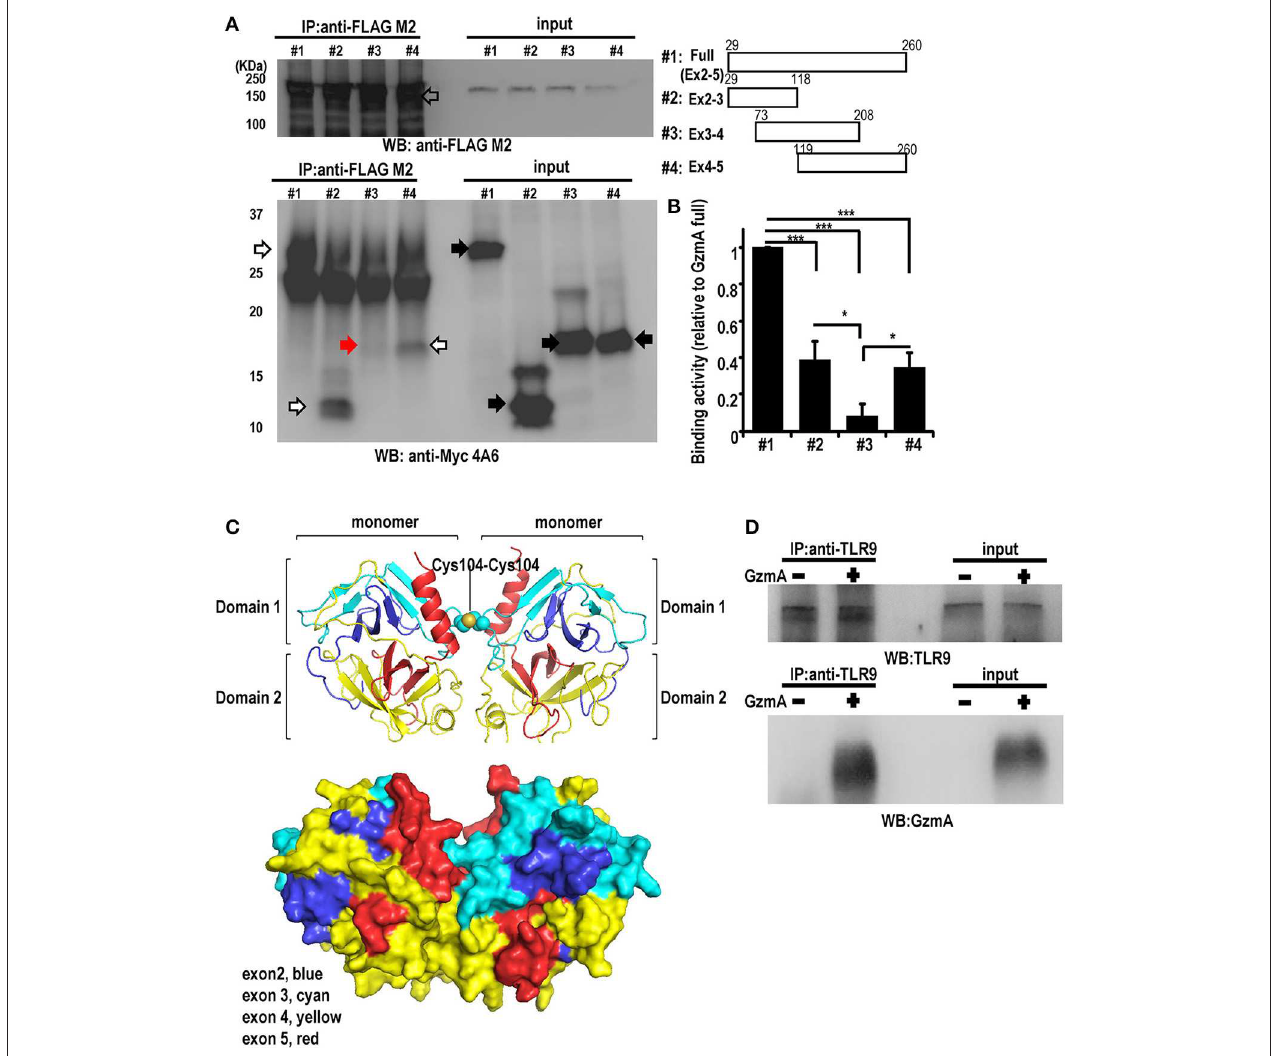
FIGURE 4 | Interaction between GzmA and TLR9. (A) Co-immunoprecipitation western blot (WB) assay for the interaction between GzmA and TLR9. cMyc-tagged full-length or truncated GzmA proteins (right) and flag-tagged TLR9 protein were expressed in HEK293T cells (left). Whole-cell lysates were subjected to immunoprecipitation using anti-Flag Ab and immunoblotted with anti-cMyc Ab. (B) Quantification of binding activity was assessed by the ratio of IP-GzmA (white and red arrows) (lower left): the ratio of input GzmA (black arrow) was calculated from that of full-length GzmA (mean ± SEM, n = 4). * p < 0.05 ; *** p < 0.001 (one-way ANOVA test with Tukey’s post-hoc test). (C) 3D structural model of mouse GzmA dimer (upper panel) generated using SWISS-MODEL Repository with its surface representation in the same view (lower panel) (72, 73). GzmA monomers are colored by exon (exon2, blue; exon 3, cyan; exon 4, yellow; exon 4, red). The Cys104-Cys104 disulfide bond between monomers is shown by spheres. This figure was created with the program PyMOL. (D) Co-immunoprecipitation western blot (WB) assay for the interaction between GzmA and TLR9 in primary FL-DCs. Whole-cell lysates were harvested 8h after culture in the absence (1) or presence (2) of GzmA. These were immunoprecipitated using anti-TLR9 and immunoblotted with anti-TLR9 or anti-GzmA Ab. Results are representative of three independent experiments.